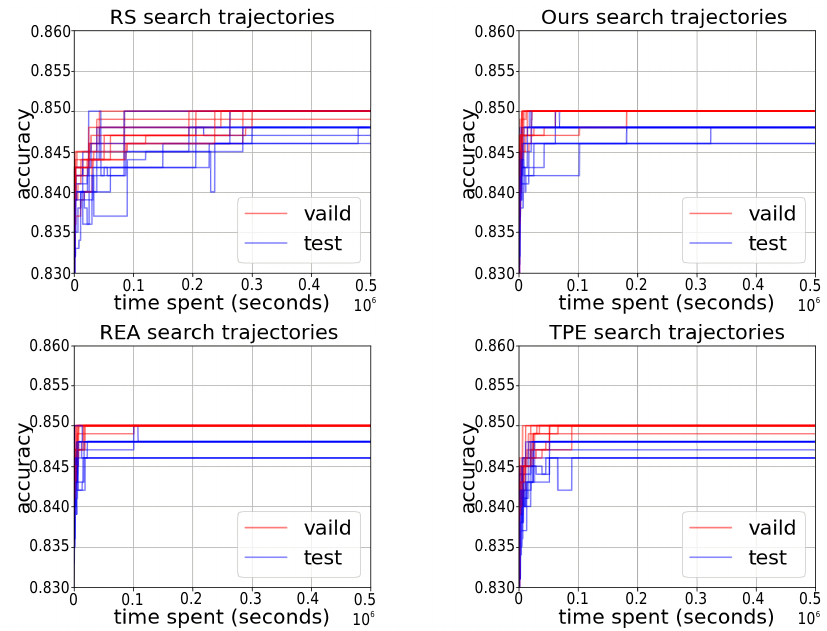
Figure 9. Comparison of the mean test accuracy along with error bars. Figure 9. Compare the mean test accuracy along with error bars.